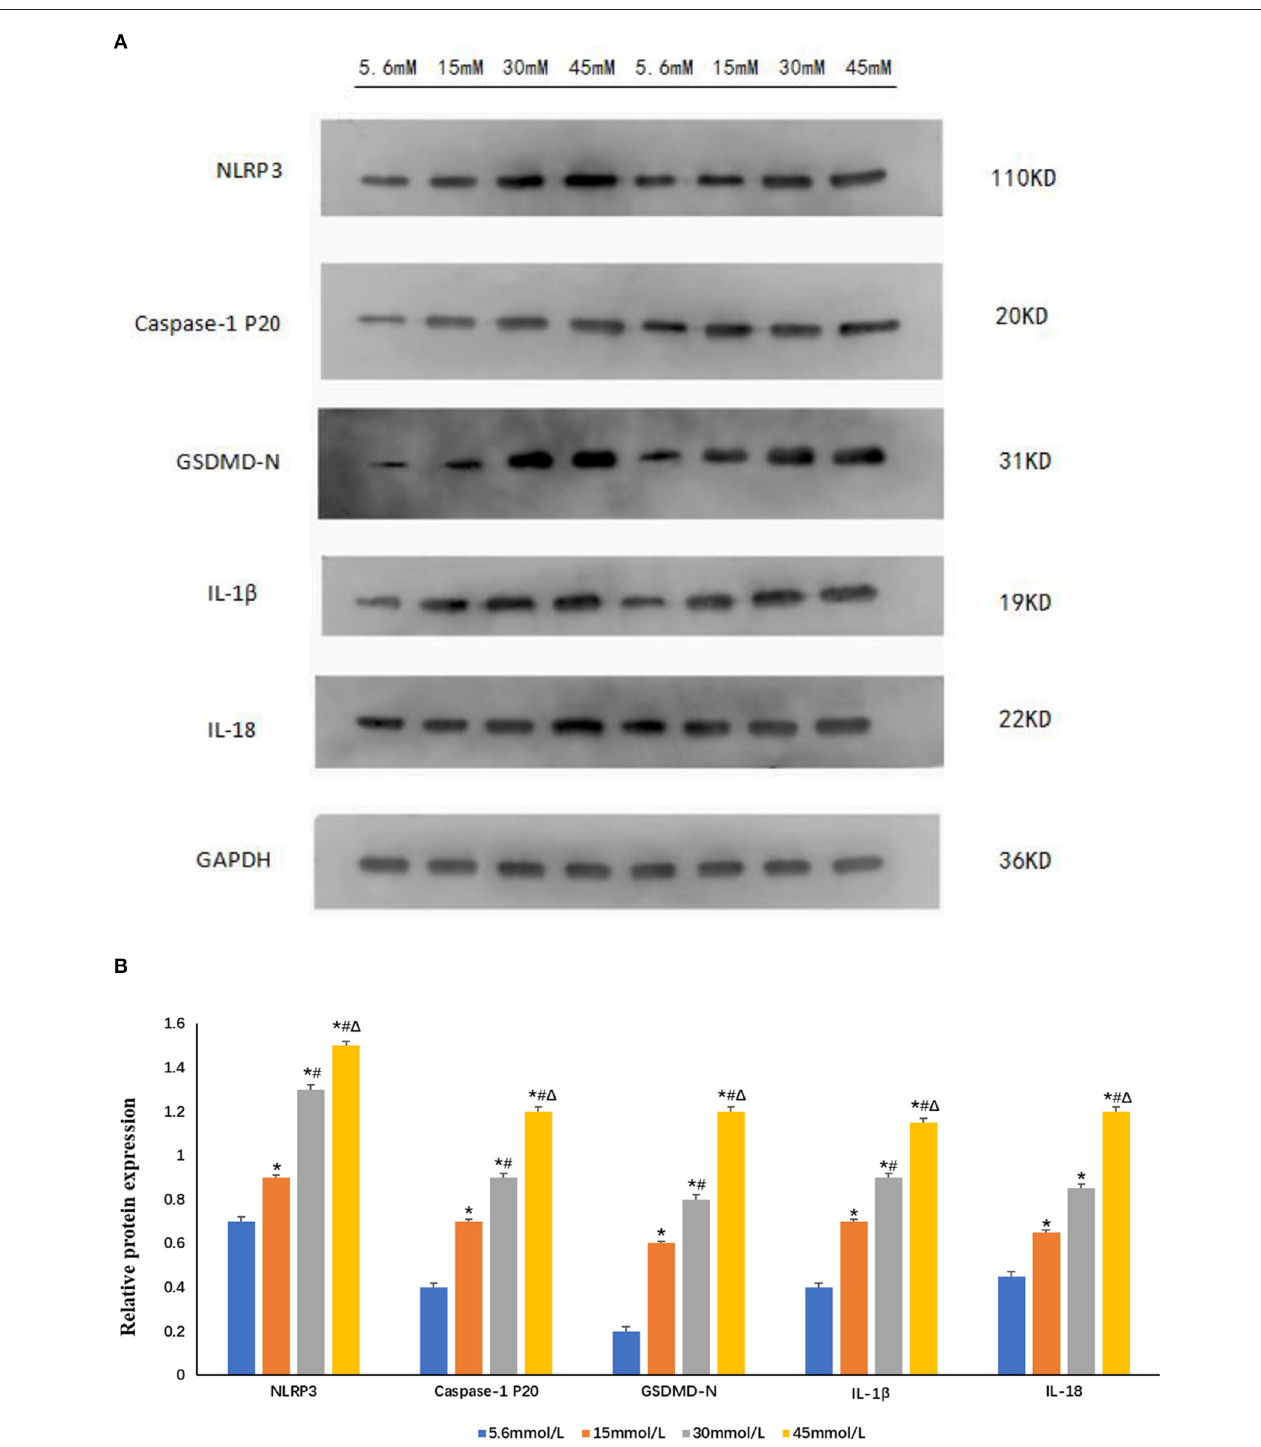
FIGURE 5 | Expression of NLRP3 and pyroptosis-related proteins increased after stimulation with different glucose concentrations in HK-2 cells. (A) Western blot showing the expression of NLRP3, caspase-1 p20, GSDMD-N, IL-1 β , and IL-18 increased in a glucose-concentration-dependent manner. (B) The protein fold change of NLRP3, caspase-1 p20, GSDMD-N, IL-1 β , and IL-18, using Gapdh as a reference gene. Data is presented as the average fold change compared to controls ± s.e.m. n = 3. * P < 0.05 vs. 5.6 mmol/L glucose group; # P < 0.05 vs. 15 mmol/L glucose group; 1 P < 0.05 vs. 30 mmol/L glucose group. n = 3.